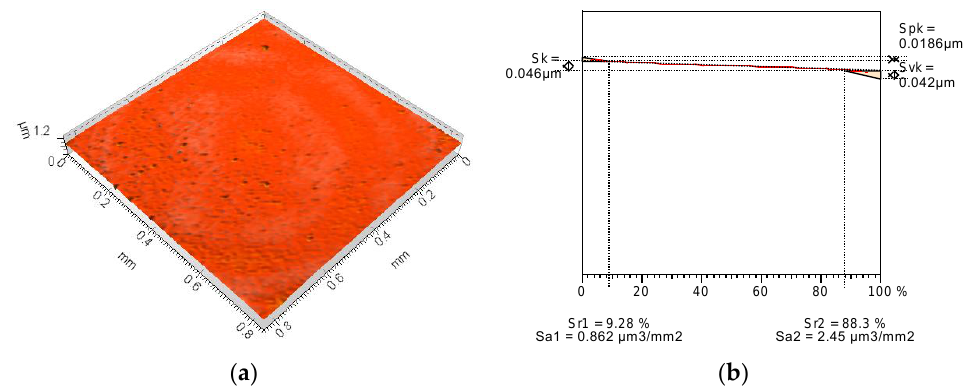
Figure 1. Base surface no. 1 (3D view) ( a ) and Abbott-Firestone curve with Sk-family parameters ( b ) [20].